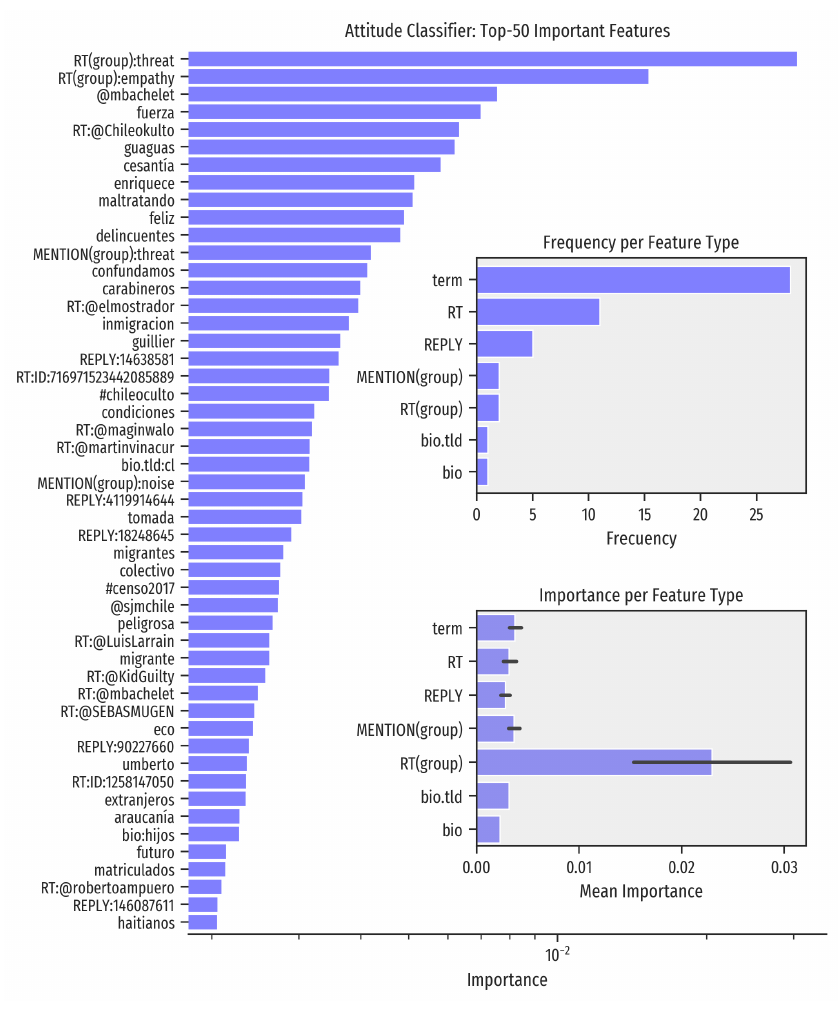
Figure 4. Attitude classification: Top 50 most important features. Table 3. Distribution of user accounts and tweets per attitude and account